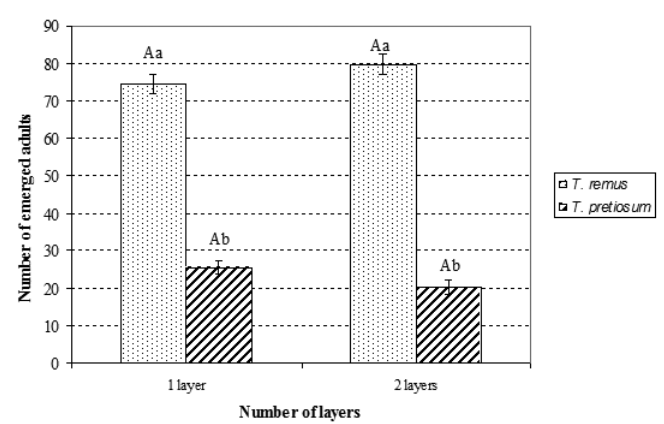
Fig. 1 - Number of adults emerging (± SEM) from 1-layer or 2-layer Spodoptera frugiperda egg masses offered to Telenomus remus and Trichogramma pretiosum simultaneously. Bars under the same lowercase letter are not significantly different (Tukey’s Test, P >0.05), when comparing different species in the same category (number of layers). Bars under the same capital letter are not significantly different (Tukey’s Test, P >0.05) when comparing the same species in different categories (different number of layers).